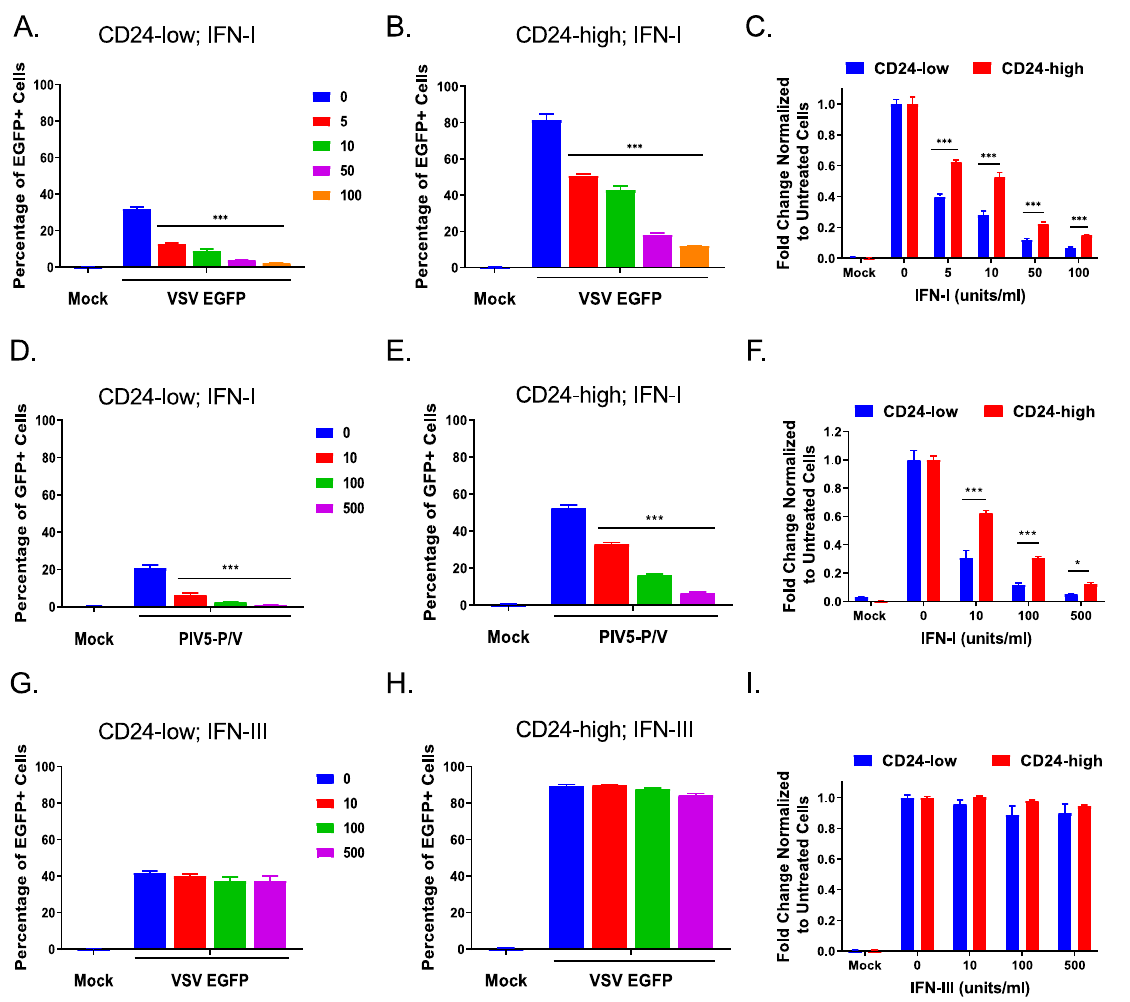
Figure 4. CD24-low and CD24-high cells differ in IFN-I-mediated sensitivity to virus infection. CD24-low ( A , D , G ) and CD24-high ( B , E , H ) cells were treated with the indicated concentrations of IFN-I ( A – F ) or IFN-III ( G – I ) for 14–17 h or 24 h, respectively. Treated cells were then either mock-infected or infected with VSV-EGFP at an MOI of 5 for 7 h (panels A – C and G – I ), and flow cytometry was performed to determine the percentage of EGFP+ cells. Alternatively, IFN-I treated cells were infected at an MOI of 5 with the PIV5-P/V virus. Flow cytometry was performed ~24 h after infection ( D – F ) to determine the percentage of GFP+ cells. To compare the relative permissivity of IFN-treated CD24-low and -high cells to VSV-EGFP or PIV5-P/V, data are expressed as fold changes normalized to respective untreated cell populations (panels C , F,I ). Values are the mean of three samples, with error bars representing standard deviation. * and *** indicate p -values of <0.033 and <0.001, respectively. Similar results were observed when CD24-low and -high cells were pretreated with IFN-I and infected with a second IFN-I-sensitive virus—the Parainfluenza Virus 5 P/V mutant (PIV5-P/V) expressing GFP [10]. As shown in Figure 4D,E, untreated CD24- low and -high cells showed ~20% and 50% GFP+ cells, respectively, demonstrating an inherent difference in their permissivity to PIV5-P/V infection. Likewise, after